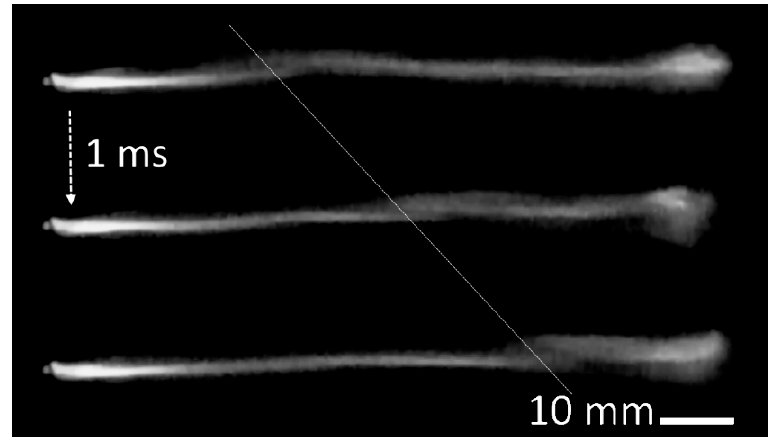
Figure 4. The spreading of a channel irregularity within the HCPJ generated at an input power of 400 W and 40 kPa pressure. Images taken from the 1000 fps video record with the single frame exposure time of 1 ms. The spatial and temporal scales are given together with the dashed line indicating spreading of the irregularity.